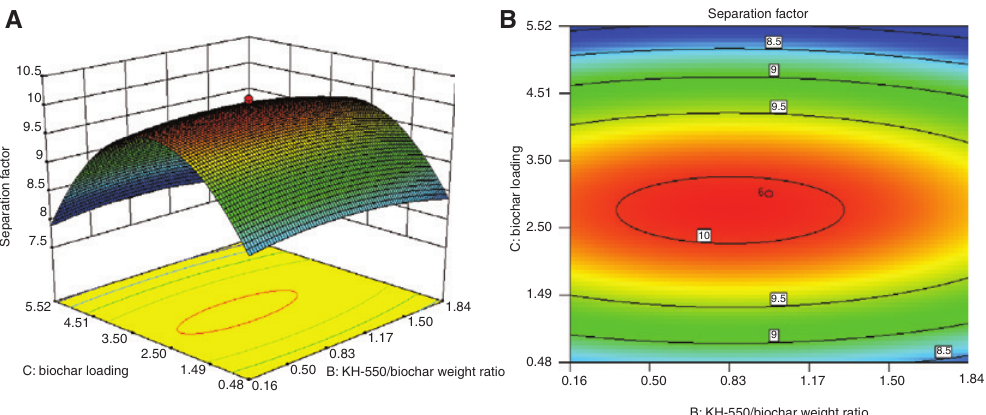
Figure 5: 3D surface plot (A) and contour plot (B) exhibiting the influences of the crosslinker/BB weight ratio and the BB loading amount on the separation factor.